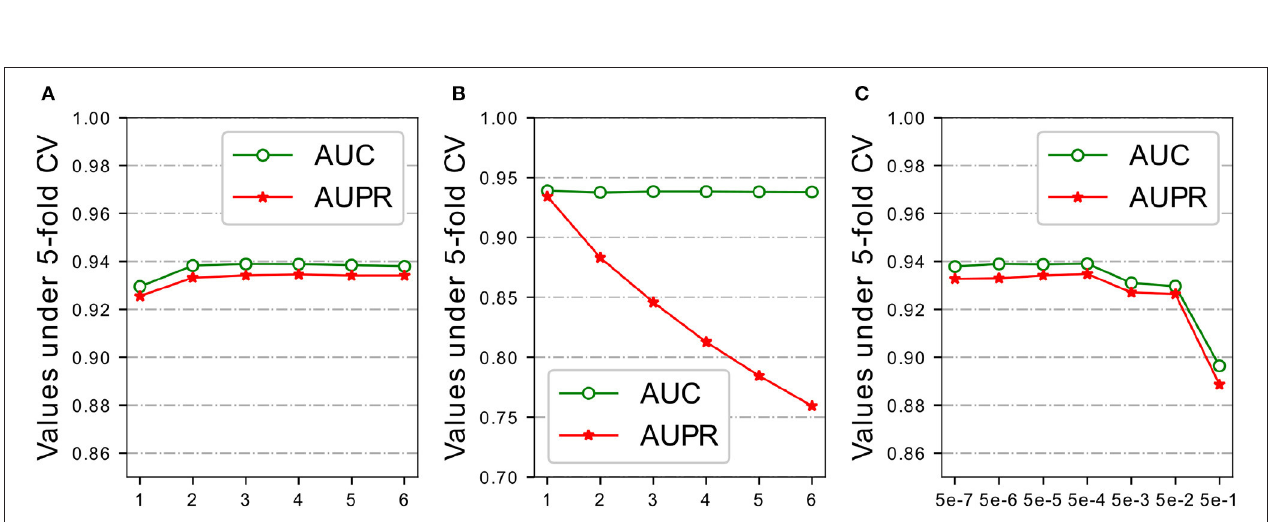
FIGURE 4 | Parameters analysis of FC layers, negative samples and regularization on HMDD v2.0 dataset. (A) # FC layers. (B) Negative sampling ratio. (C) Penalty factor λ